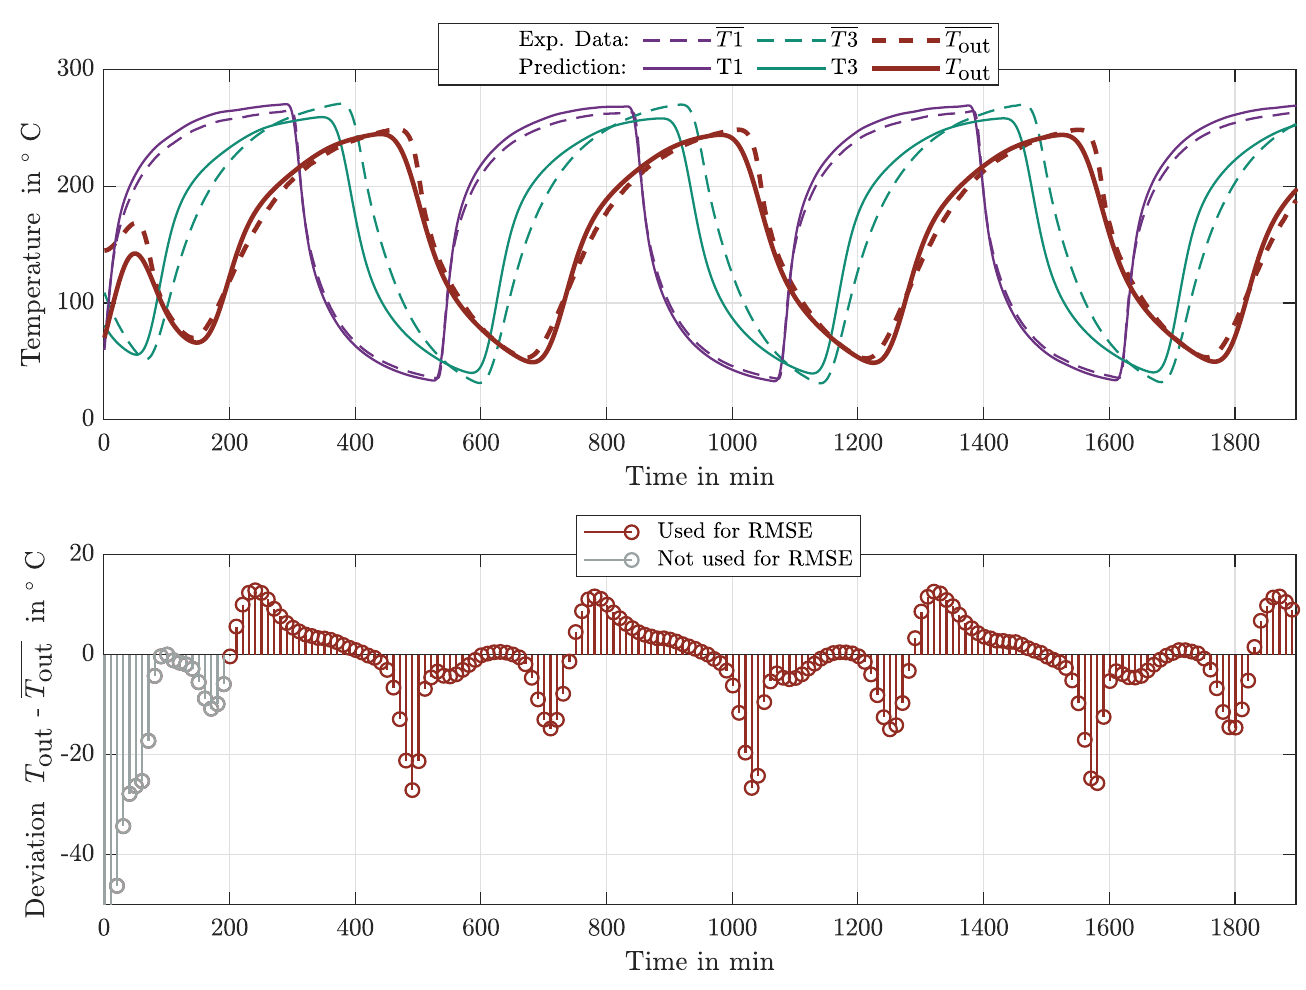
Figure 4. Results of the extended grey-box model I for measurement series